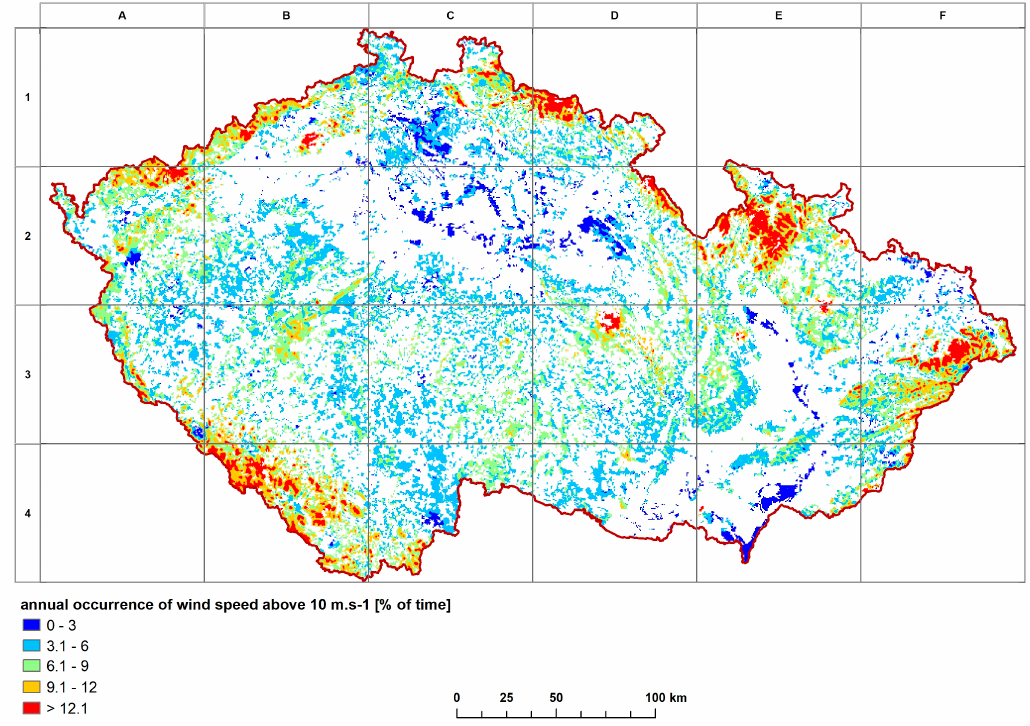
Figure 5. Categories of wind gust (WG) risk based on long-term annual occurrence of wind speeds above 10 m s − 1 (WS10).